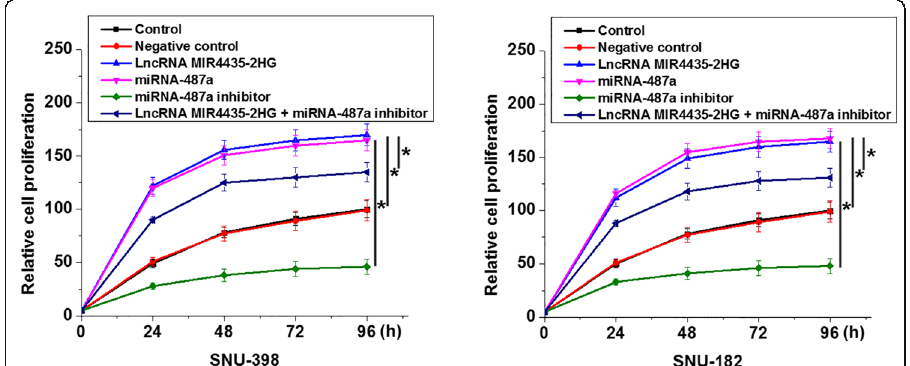
Fig. 5 MIR4435-2HG regulates HCC cell proliferation through miRNA-487a. Compared with control (C) and negative control (NC) groups, overexpression of MIR4435-2HG and miRNA-487a led to the promoted proliferation of cells of HCC cell lines. In addition, miRNA-487a knockdown led to the inhibited proliferation of cells of HCC cell lines and partially attenuated the enhancing effects of MIR4435-2HG overexpression on cancer cell proliferation. * p <